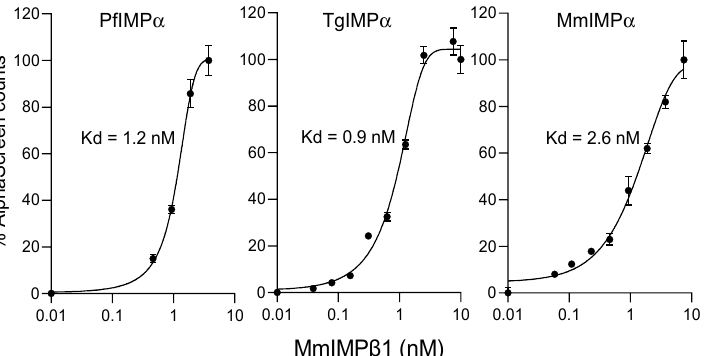
Figure 2. PfIMP α and TgIMP α can bind with high affinity to mammalian IMP β 1 in comparable fashion to MmIMP α . AlphaScreen technology was used to determine the Kd value of His-tagged IMP α s (30 nM) binding to biotinylated-GST-MmIMP β 1 (5 nM). Data points in the figures represent the mean ± SEM from quadruplet wells from a single typical experiment from a series of three independent experiments (see Table 2 for pooled data). Table 2. Summary of binding analysis data of IMP α s with MmIMP β 1 from AlphaScreen analysis. Binding Interaction